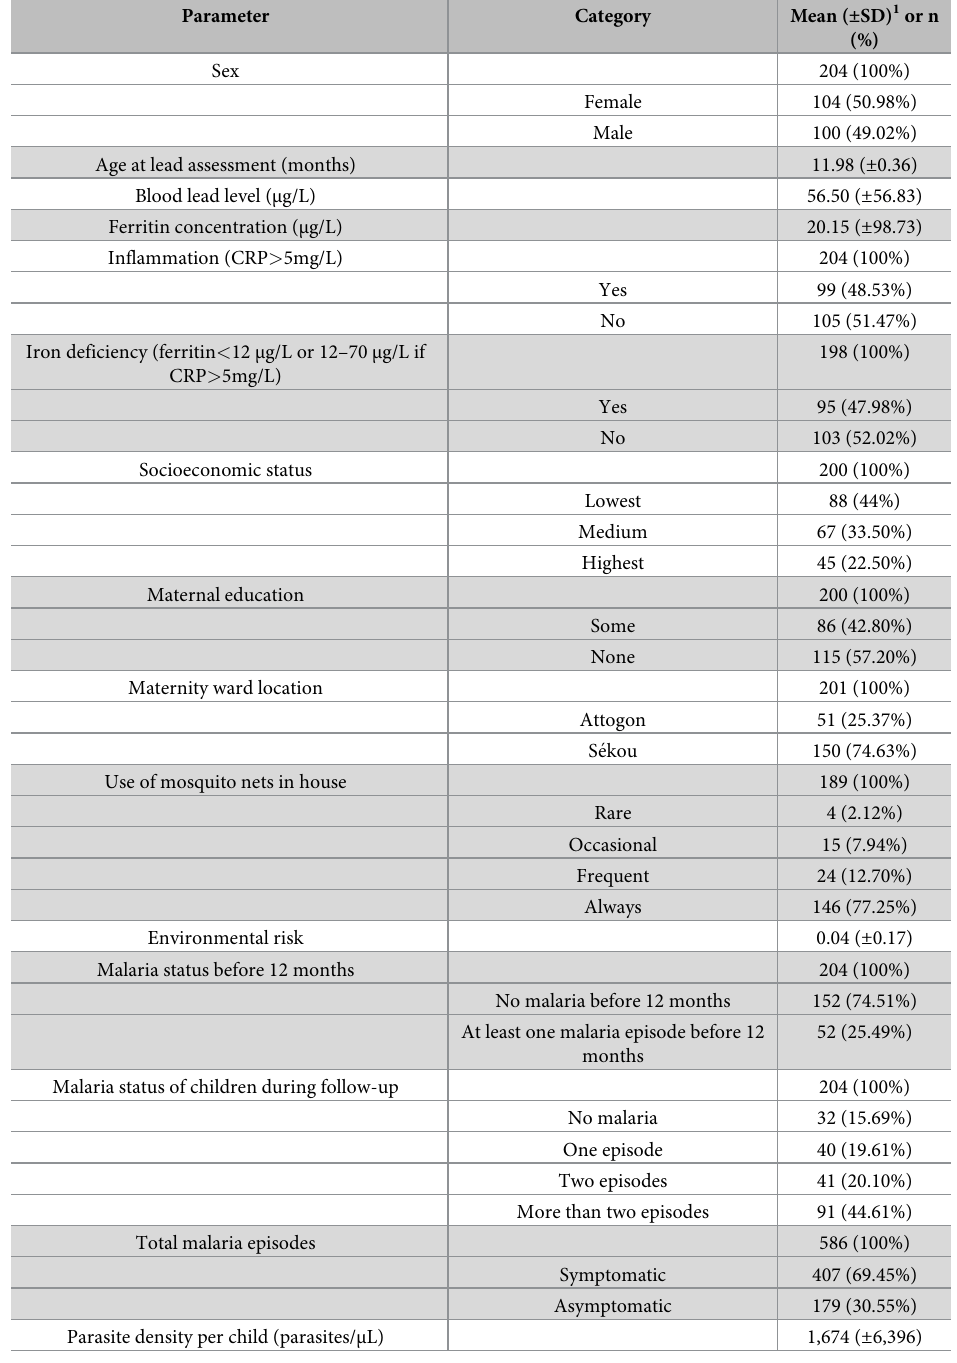
Table 1. Demographic and clinical characteristics of participating children (N =